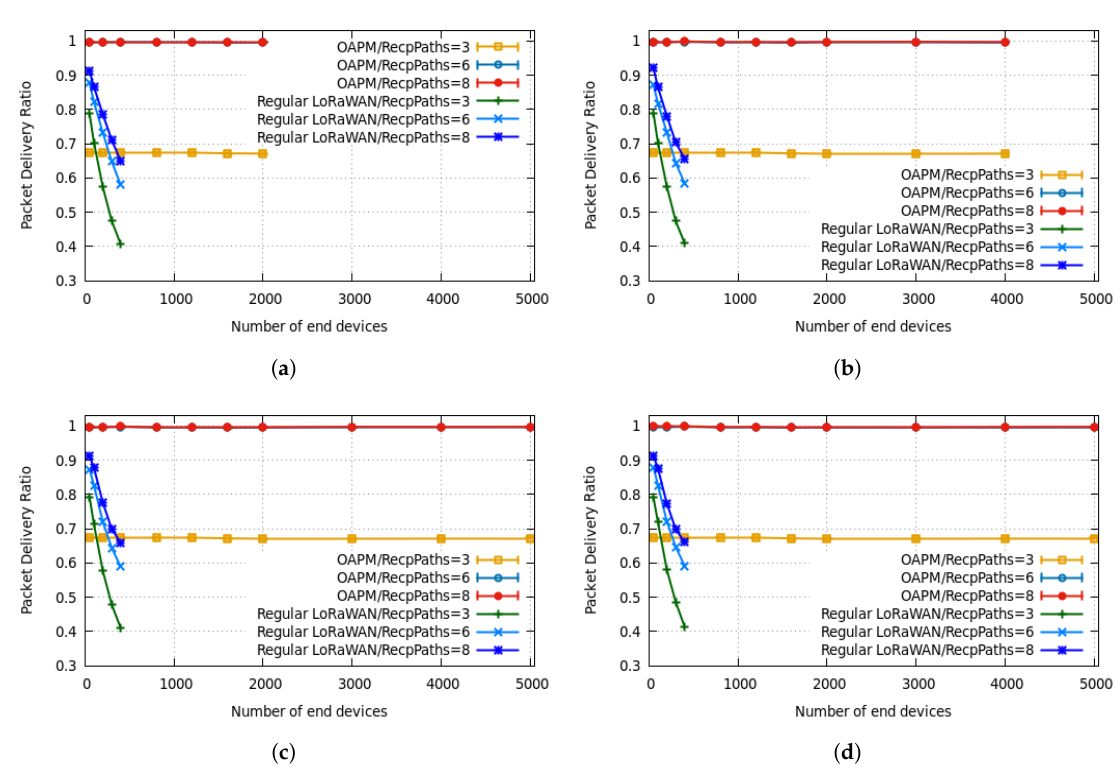
Figure 10. Packet delivery ratio versus number of end devices, for different numbers of gateway Receive Paths and different time window durations. ( a ) TW = 100 s; ( b ) TW = 200 s; ( c ) TW = 300 s; ( d ) TW = 400